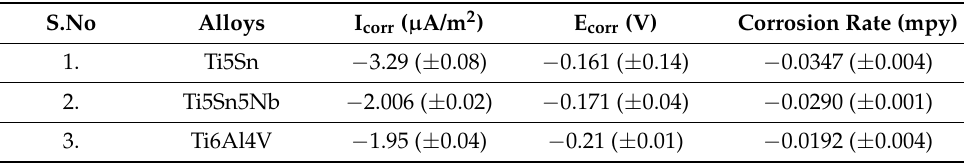
Figure 6. Tafel curves of the alloys in SBF solution maintained at PH of 7.4 and a temperature range of 36.5 °C. Red line shows Ti5Sn. Blue line represents Ti6Al4V, and green line indicates Ti5Sn5Nb. Table 6. Parameters of corrosion found via Tafel